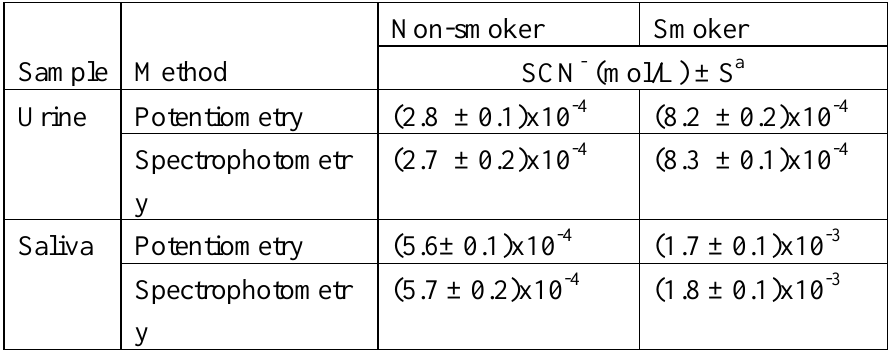
Table 2 . Determination of thiocyanate in biological